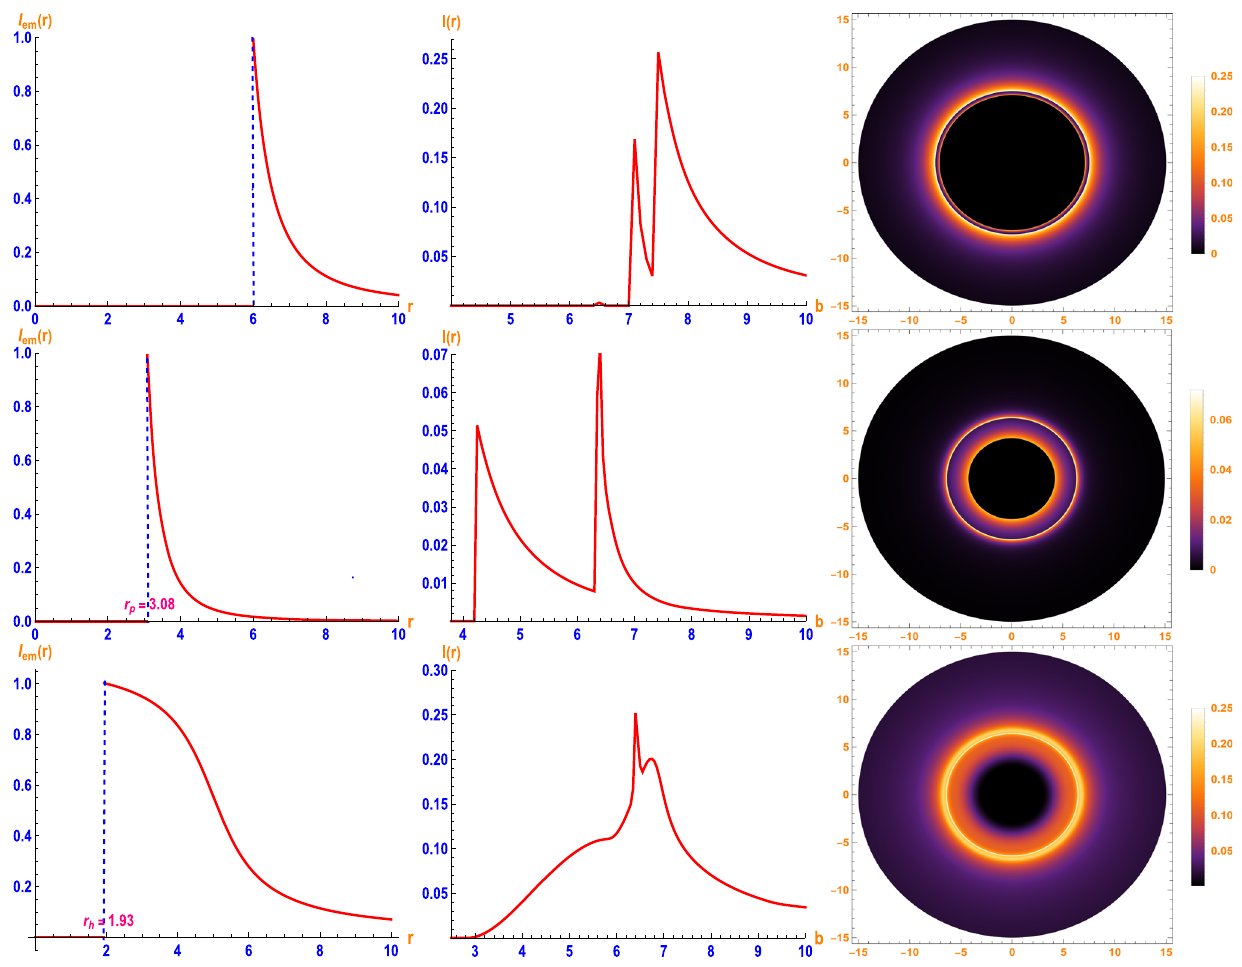
Fig. 7 Optical observation of thin disk accretion near the BH with different emission matter profiles, viewed from a face-on orientation. From left to right panels, the depicted graphs are reflecting the various